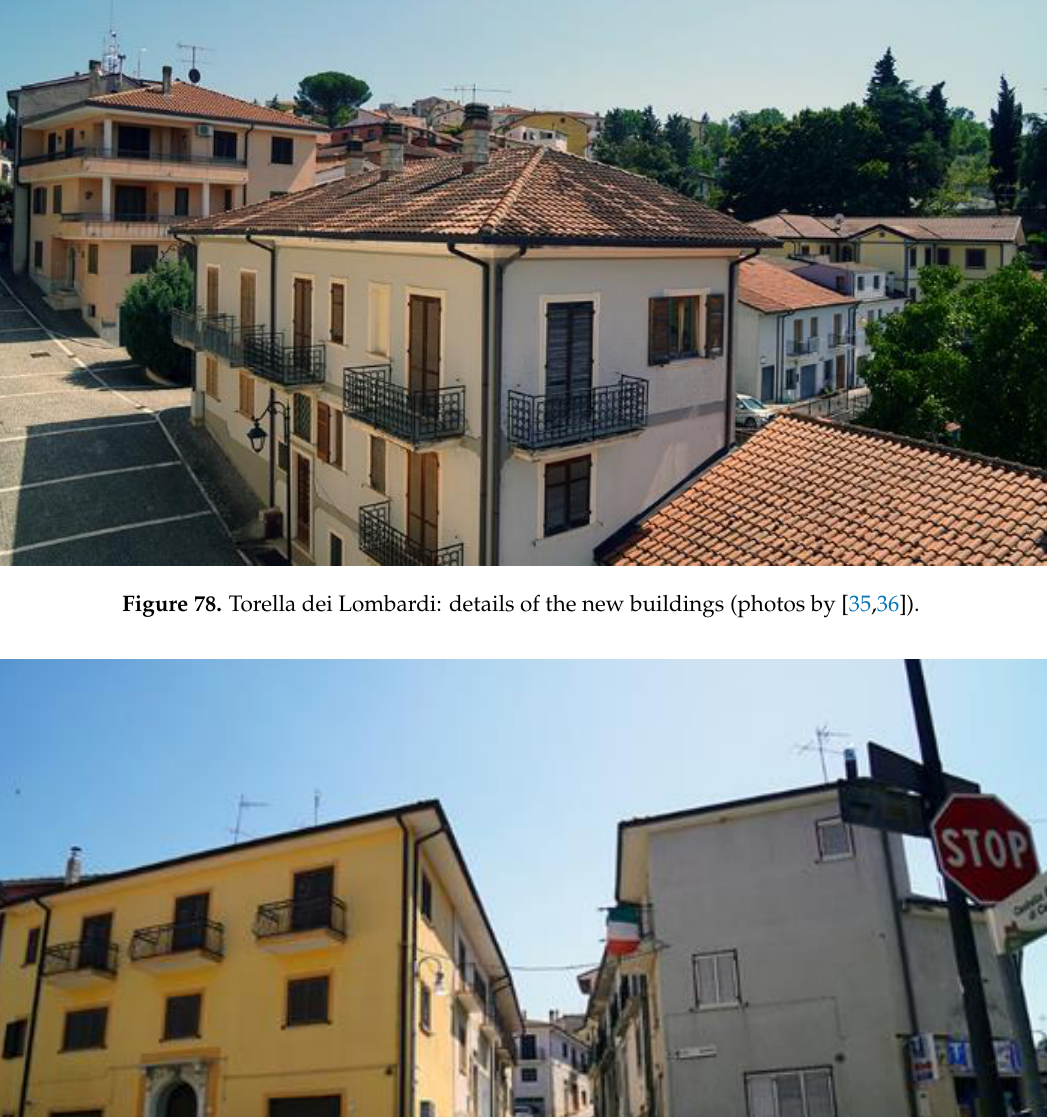
Figure 77. Torella dei Lombardi: stone plaque to remember the victims of the 1980 earthquake (photos by [35,36]).